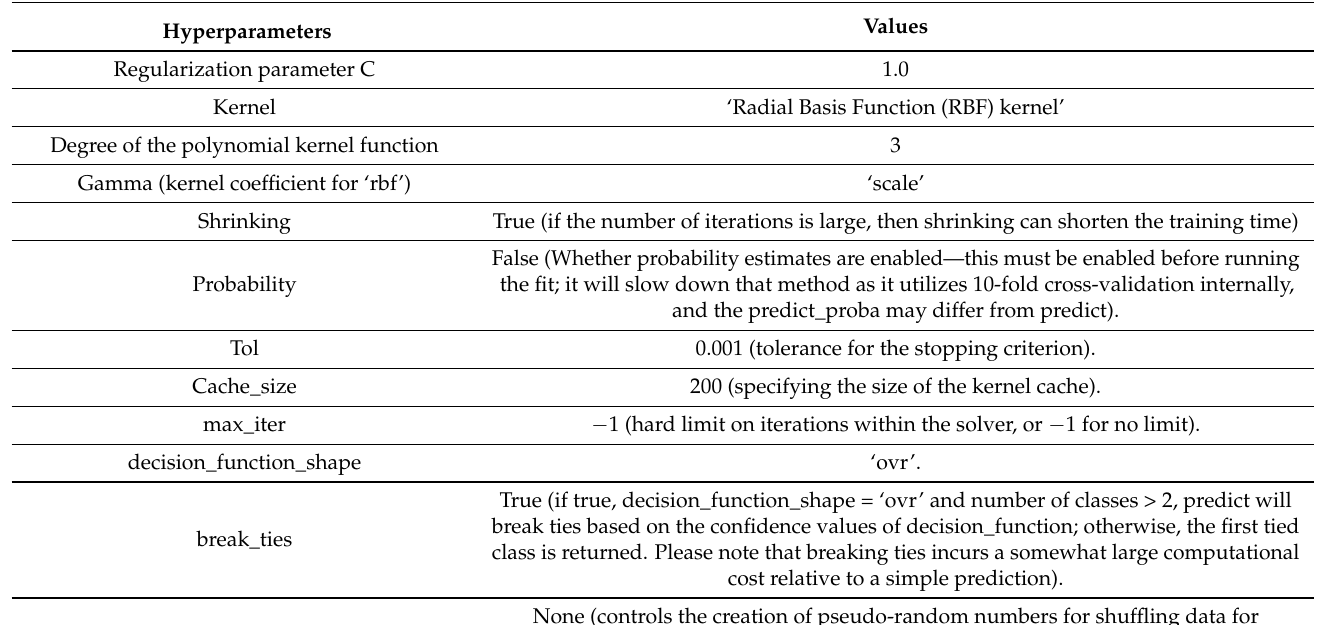
Table 5. The default settings used to implement the